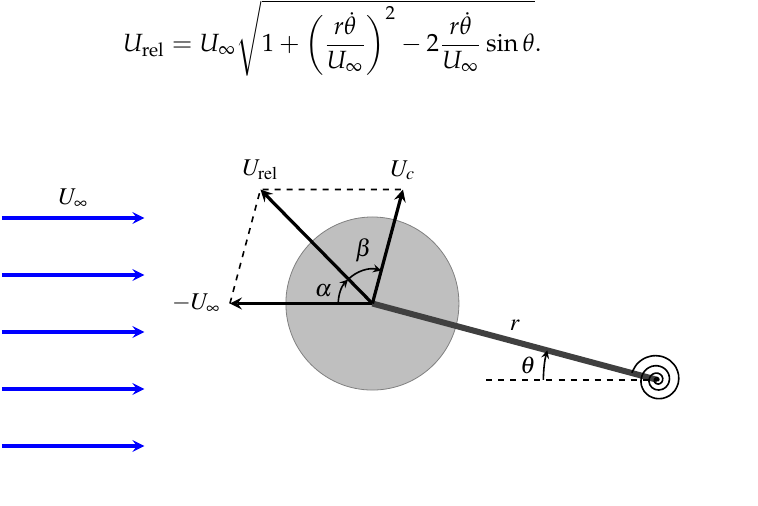
Figure 2. Two-dimensional representation of the cylinder kinematics under